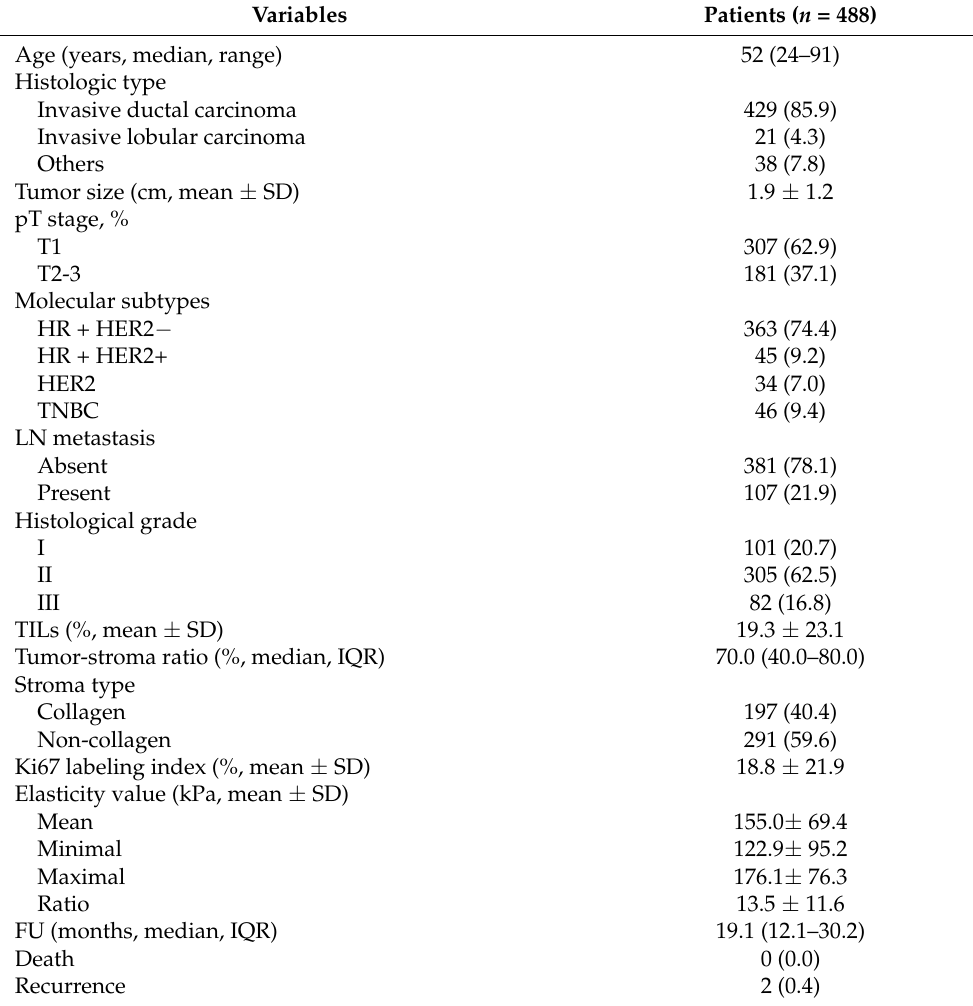
Table 1. Basal characteristics of